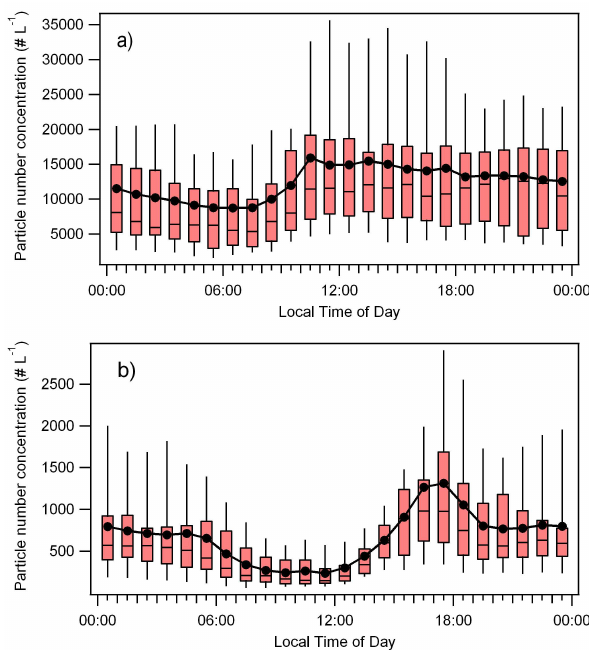
Fig. 7. Diurnal variation of (a) submicron (0.3–1µm), and (b) su- permicron (1–20µm) particle number concentration as measured by the OPC on the mast near the forest floor. The black markers and lines show the means, while the boxes represent the inter-quartile range and the whiskers represent the 10% to 90% range.